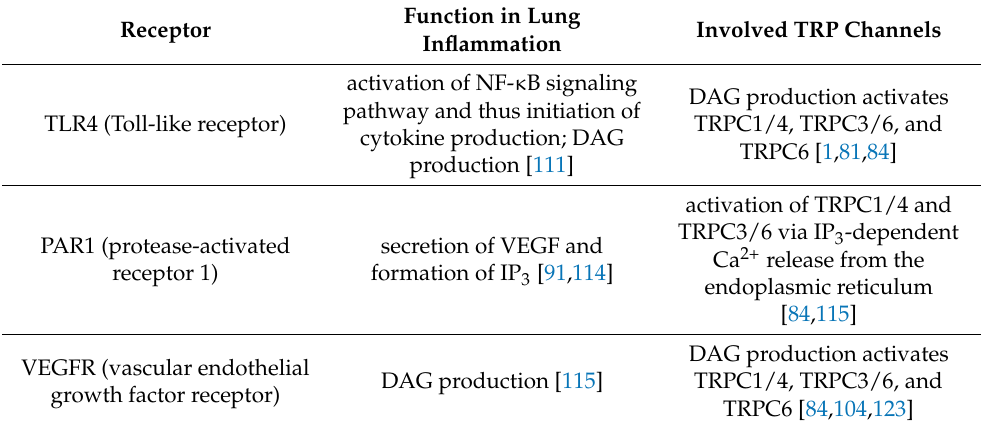
Table 2. An overview of activated receptors in lung inflammation and their link to TRP channels. Function in Lung Involved TRP Channels Receptor Inflammation activation of NF- κ B signaling pathway and thus initiation TLR4 (Toll-like receptor)